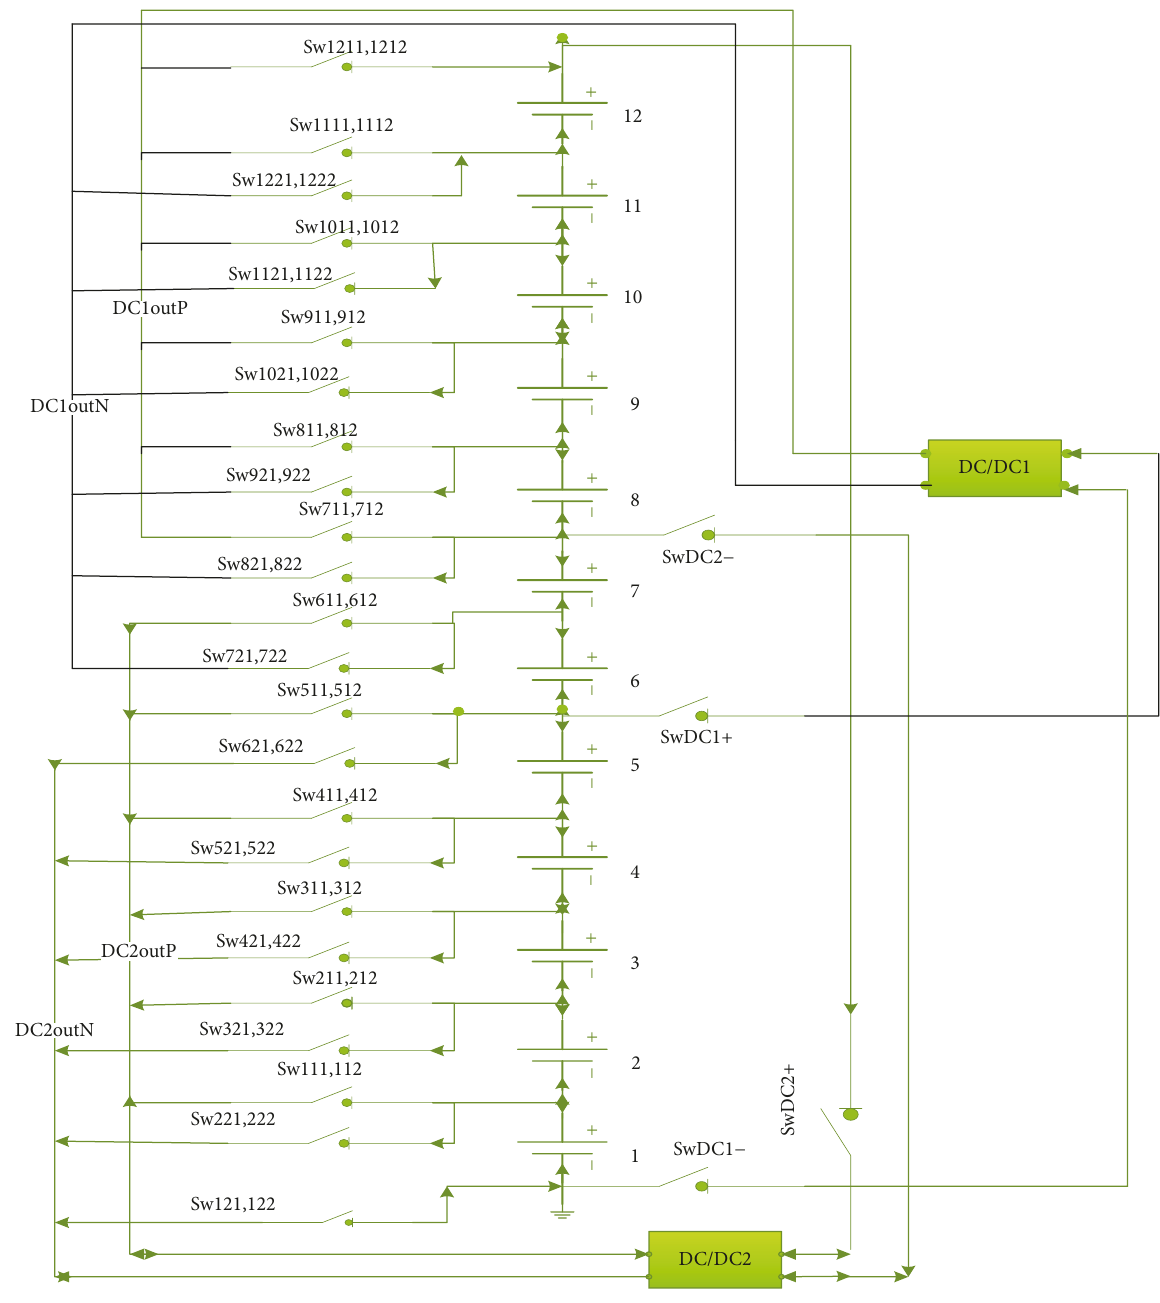
Figure 3: Active cell balancing